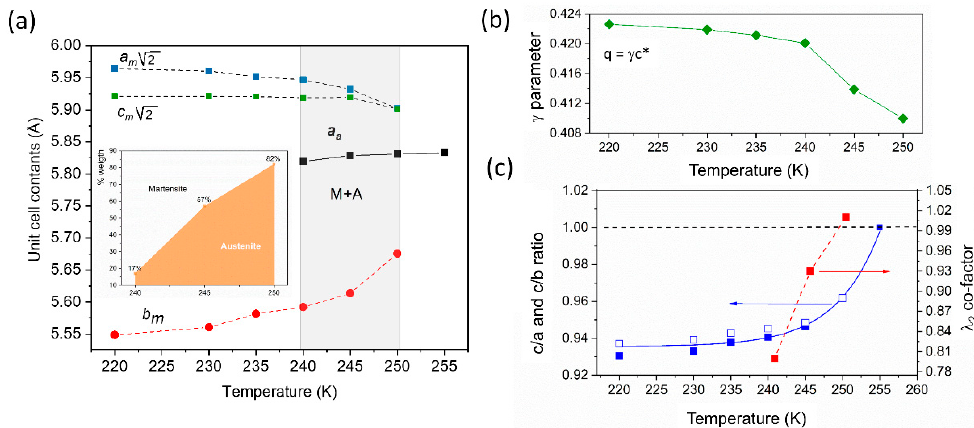
Figure 4. ( a ) Unit cell parameter change versus temperature. The a and b parameters are rescaled to the austenitic lattice. The grey region indicates the temperature range with coexistence of austenite and martensite. Inset: reciprocal amount of parent and product phase during the MT. ( b ) Temperature dependence of the γ variable of the modulation vector. ( c ) Tetragonality parameters c / a , c / b , and co-factor λ 2 against temperature.